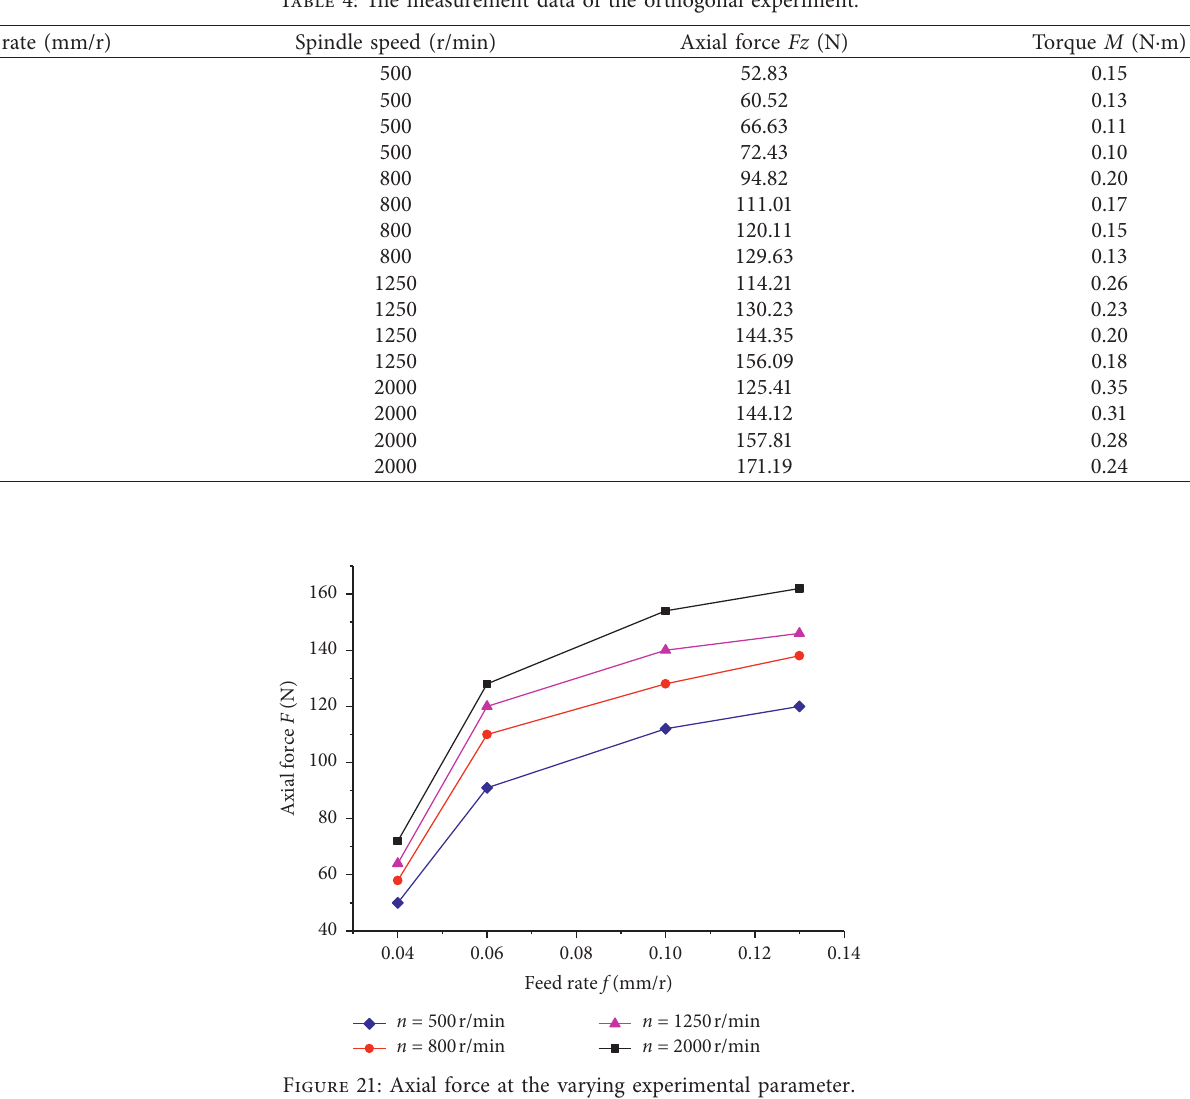
Table 4: The measurement data of the orthogonal experiment.